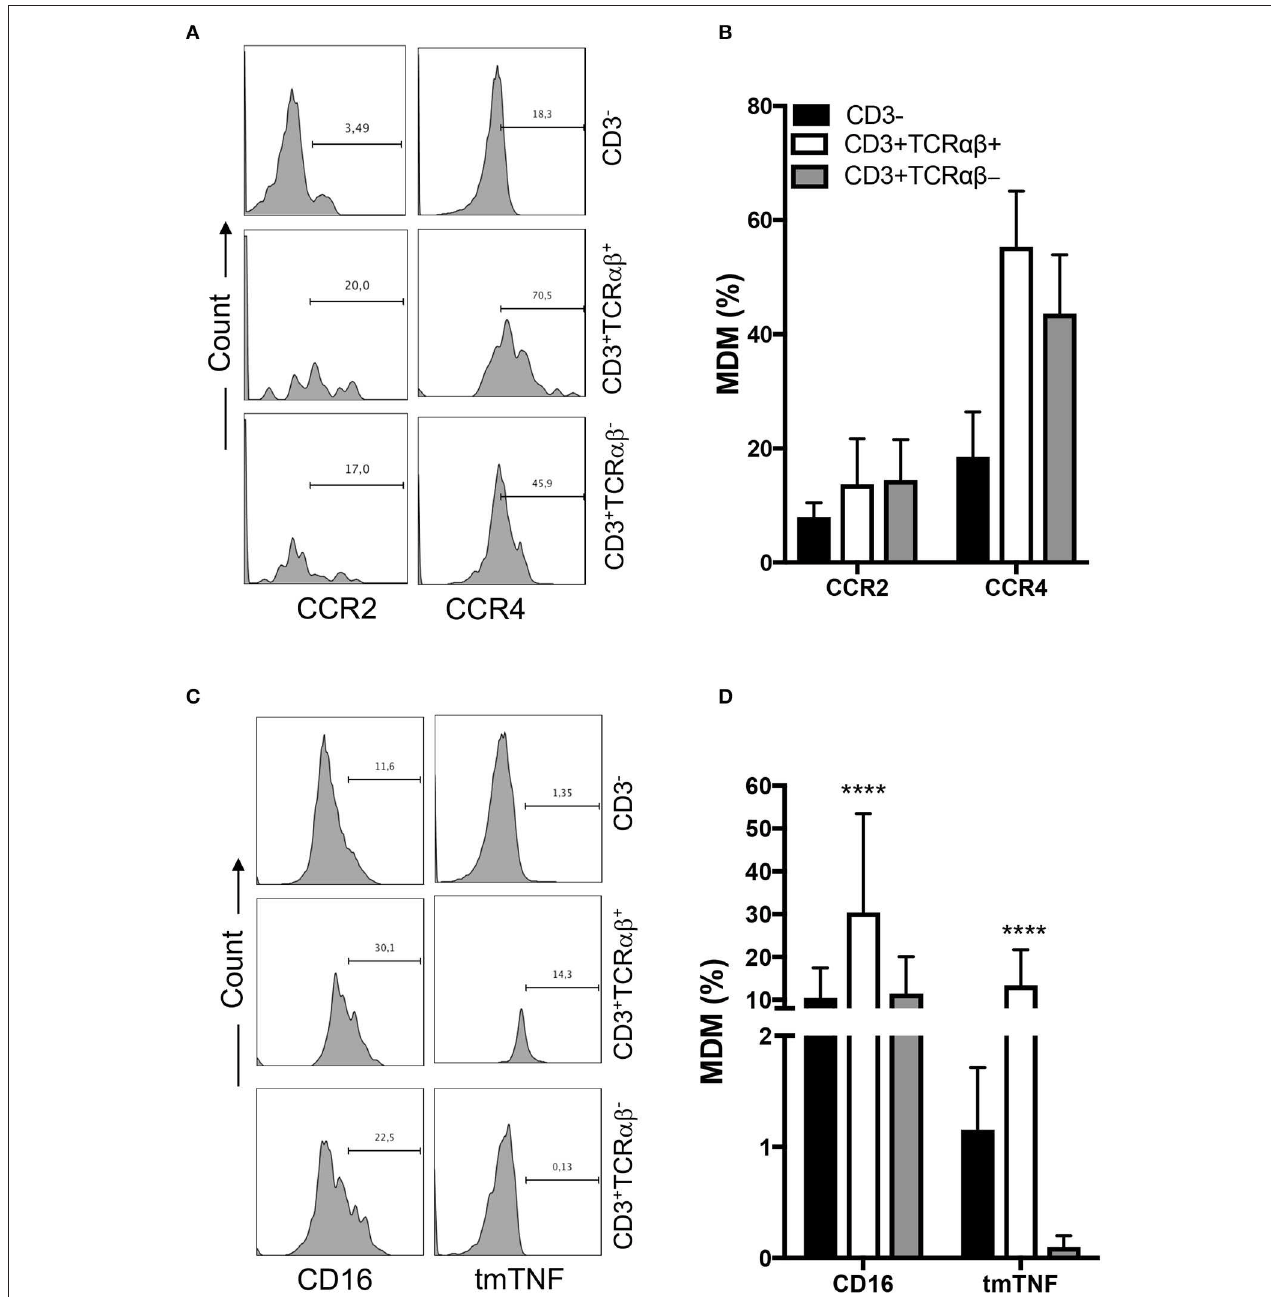
FIGURE 3 | CD3 + TCR αβ + MDM express chemokine receptors and tmTNF. Human monocyte-derived-macrophage were obtained at the 7th day post-culture and prepared for flow cytometry; the CD3 + MDM subpopulations were delimited. (A) Representative histogram showing the expression of CCR2 and CCR4 inside of each CD3 + MDM subpopulation. (B) Frequency of MDM subpopulations expressing chemokine receptors. (C) Representative histogram showing the expression of CD16 and tmTNF inside of each CD3 + MDM subpopulation. (D) Frequency of MDM subpopulation expressing CD16 and tmTNF. The bar graphs show the mean ± SD of